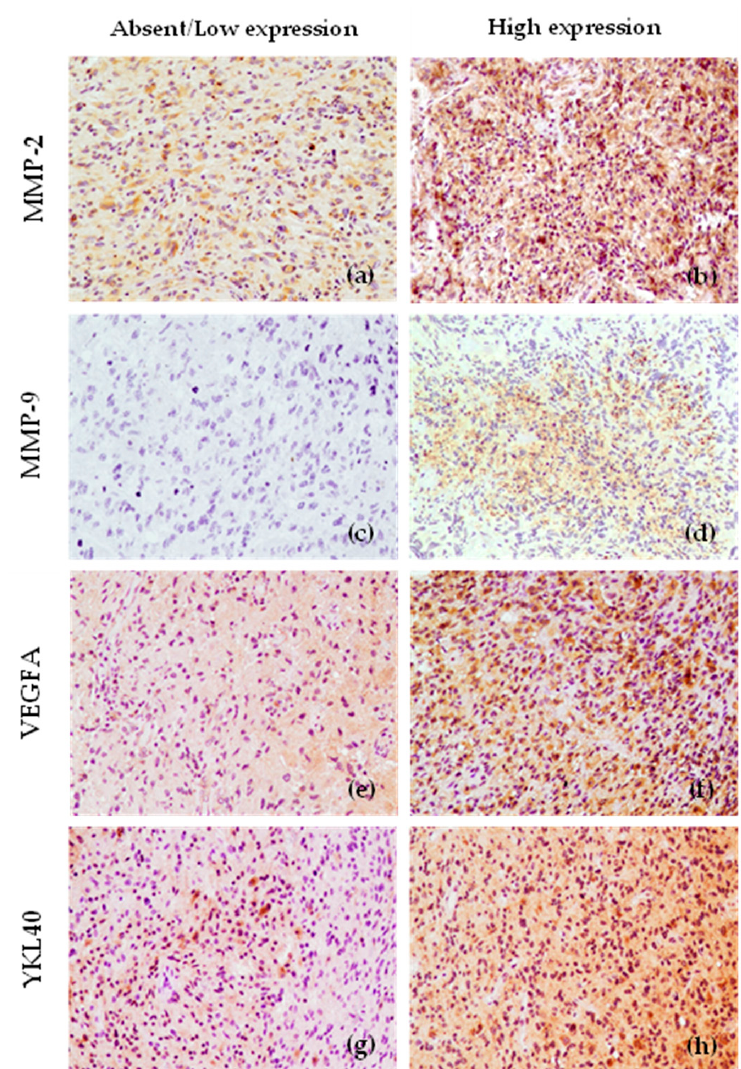
Figure 1. Representative images of the IHC analysis of MMP-2 ( a , b ), MMP-9 ( c , d ), VEGFA ( e , f ), and YKL40 ( g , h ) in human GB samples with absent/low ( a , c , e , g ) and high expression ( b , d , f , h ) of each protein. Magnification: 200 ×.